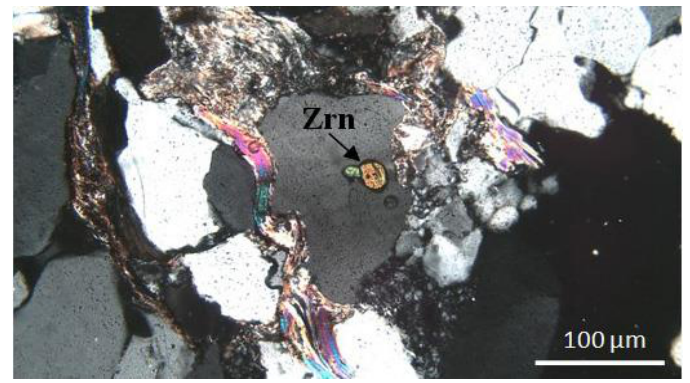
Figure 13. Tourmaline (Tur): crossed polars, 100× magnification. The sandstone binder represented a pore or primary type; its share ranged from 26% to 52.3%. It is a cement-type mixed binder in which the mineral composition was dominated by microcrystalline quartz, carbonate minerals, and clay minerals. No matrix